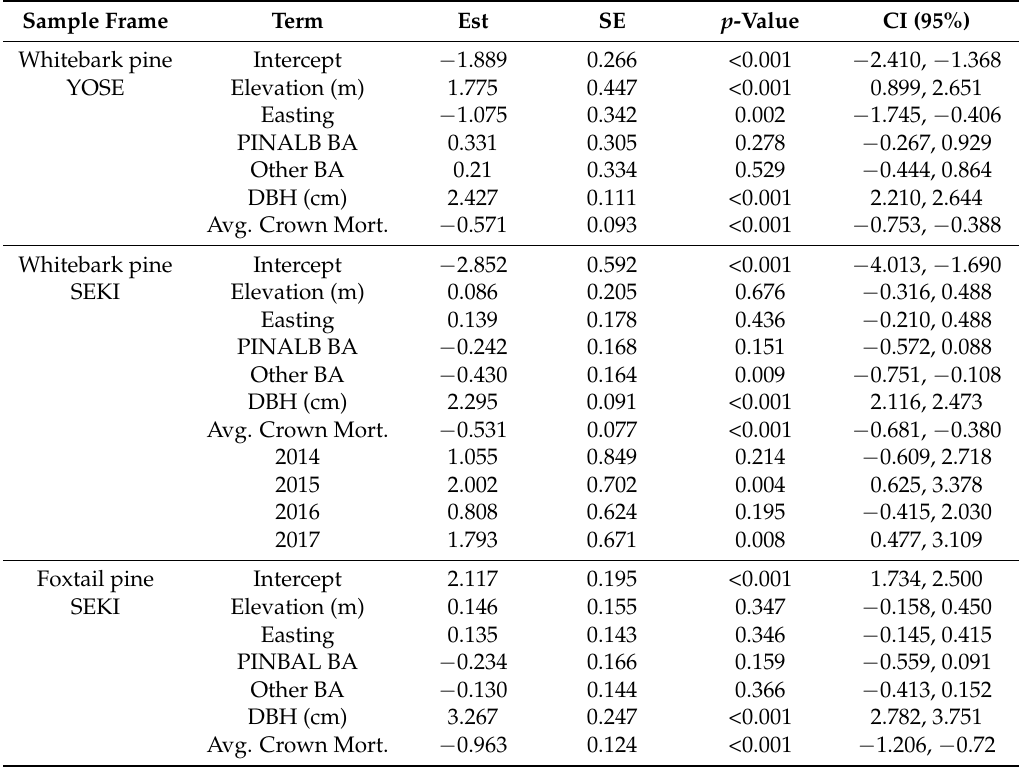
Table 3. Standardized regression estimates (Est. log-odds), standard errors (SE), p -values, and 95% confidence intervals (CI) from the Generalized Linear Mixed Model of the probability of producing cones (no = 0, yes = 1) for all sample frames. YOSE = Yosemite National Park, CA, USA. SEKI = Sequoia and Kings Canyon National Parks, CA, USA. BA = basal area (m 2 /ha), DBH = diameter at 1.37 m, Easting = UTM E, NAD83, Avg. Crown Mort. = average crown